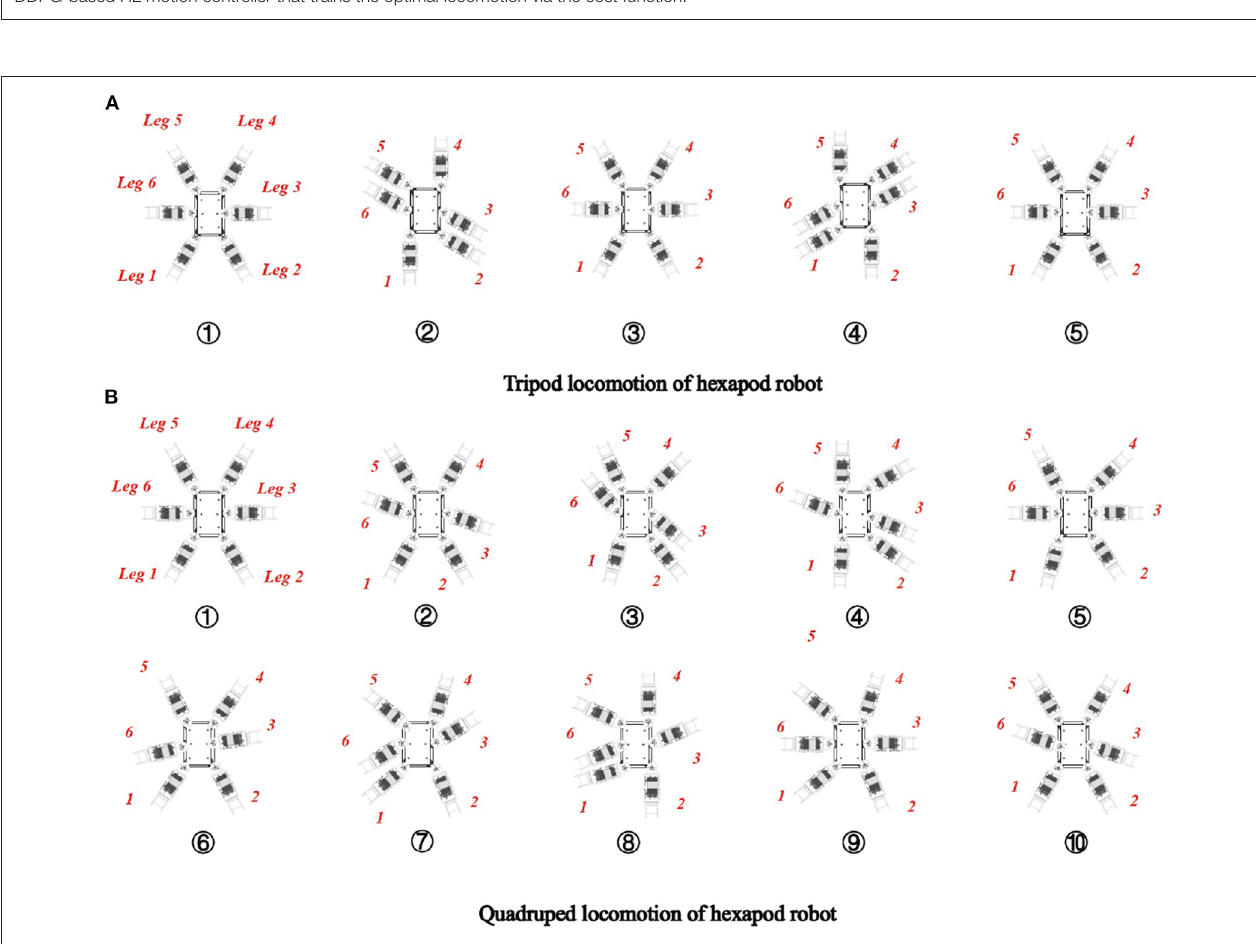
leg 1, leg 3, leg 5 and { } leg 3 leg 1, leg 4 leg 6 leg 2, leg 5 , , , and to move { } { } { } { }